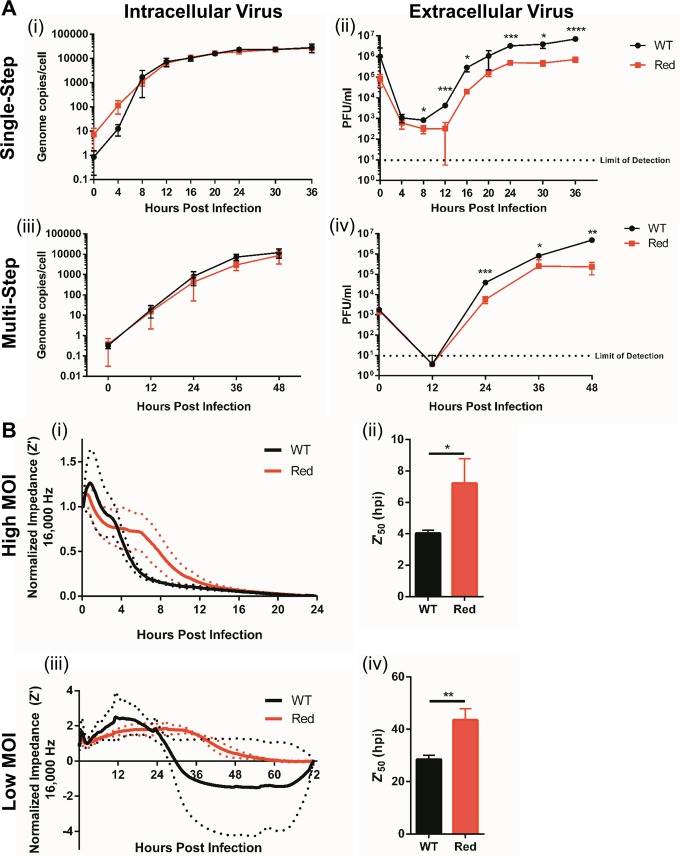
ECIS identifies the growth impairments of recombinant FHV-1. (A) CRFK cells were infected with FHV-1-gD-DsRed or WT FHV-1 at an MOI of 3 or 0.01 to measure single-step (graphs i and ii) or multistep (graphs iii and iv) growth curves, respectively, with conventional viral infectivity assays. qPCR was used to quantify intracellular genomic viral DNA copy numbers, and standard plaque assays were used to quantify extracellular virus titers. (B) Normalized impedance (Z′) values of CRFK cells infected with FHV-1-gD-DsRed or WT FHV-1 at a high MOI of 3 (i) or a low MOI of 0.01 (iii). Half-maximal Z′ (Z′50) values for impedance curves based on data from graphs i and iii were determined (graphs ii and iv, respectively). *, P < 0.05; **, P ≤ 0.01; ***, P ≤ 0.001; ****, P ≤ 0.0001.